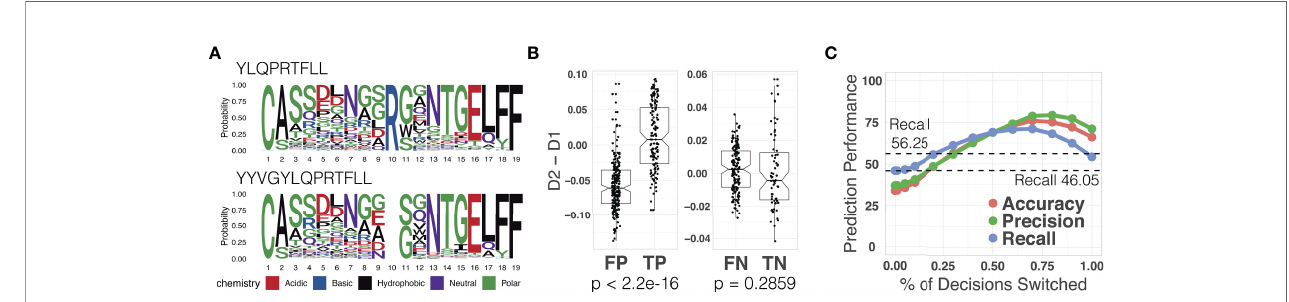
FIGURE 6 | (A) TCR sequence logos binding to the novel epitope YLQPRTFLL and the reference epitope YYVGYLQPRTFLL. (B) The binding con fi dence score ( D 2 - D 1 ) of TCRs predicted as positive (left) and negative (right) in regard to the SARS-CoV-2 novel epitope YLQPRTFLL. The average scores offalse positive and true positive TCRs showed a signi fi cant difference (p-value < 2.2 × 10 -16 ), while those offalse negative and true negative showed no signi fi cant difference (p-value = 0.2859 ), indicating that the binding con fi dence score can be used to further distinguish the false positive and true positive TCRs in out-of-sample prediction. (C) Prediction performance of the novel novel epitope YLQPRTFLL achieved by changing ATM-TCR ’ s decision using the con fi dence score. The x-axis represents the percentage of samples for which we changed the decisions and y-axis represents the prediction performance (accuracy, precision, and recall). When x is 70% ( k = -0.01 ) it achieved the best performance improvement in recall. This improved out-of-sample recall of 46.05%